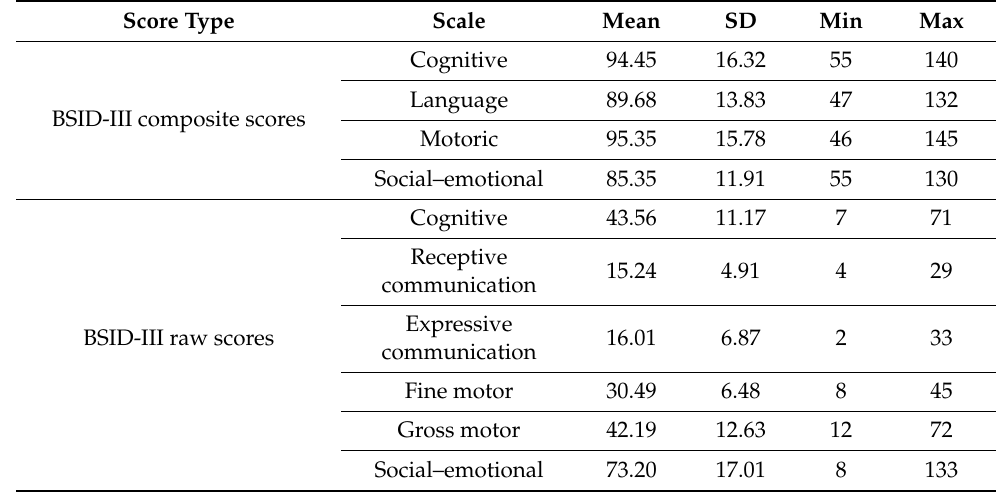
Table 2. Descriptive statistics of BSID-III scores ( n = 445).